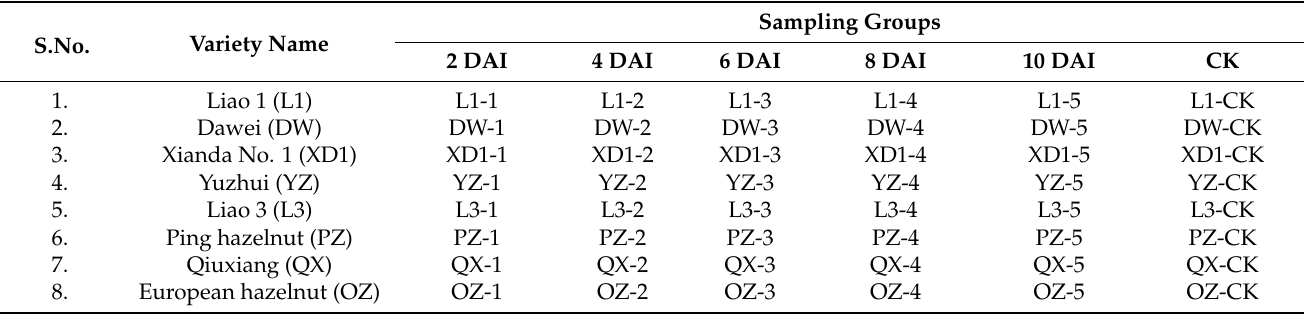
Table 1. List of hazelnut varieties and sample groups used in the current